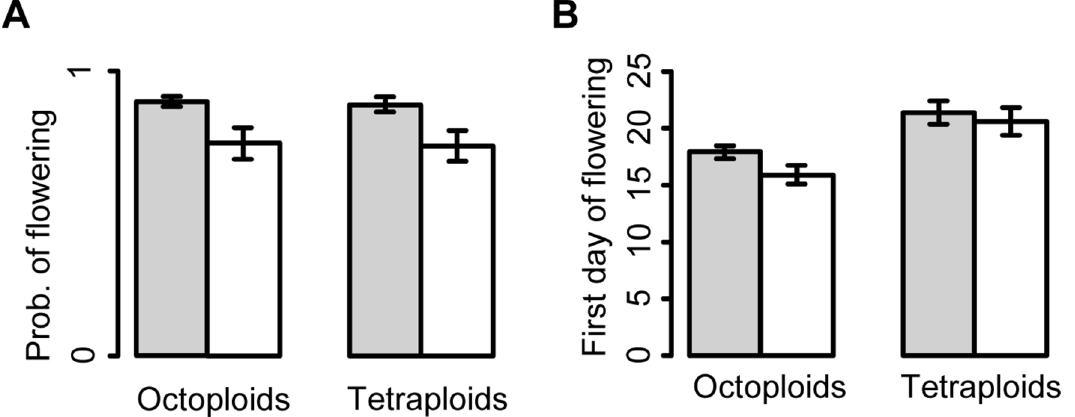
Figure 1. Effects of experimental damage on probability of flowering and phenology in Cardaminepratensis . The herbivore damage treatment was a combination of feeding by the larvae of the butterfly Anthocharis cardamines and clipping. All responses were recorded the year after the damage treatment. The bars show mean values for 25 tetraploid and 28 octoploid populations for six responses: a. probability to flower and b. first day of flowering. Grey bars are responses for undamaged plants, and open bars are damaged plants. First day of flowering was equal to number of days from first of May until first open flower. Error bars represent 6 1SE.